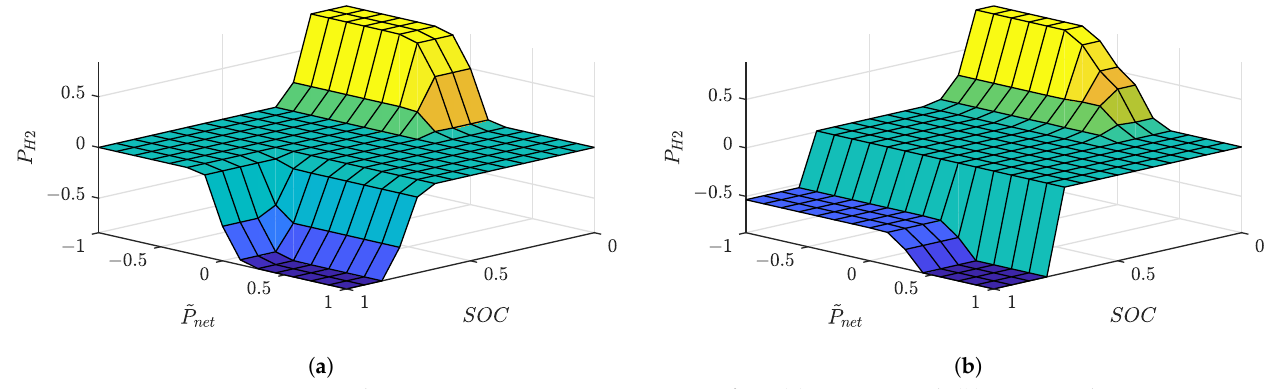
Figure 16. Fuzzy logic energy management output surface. ( a ) Expert tuned. ( b ) Optimized. The performance indicators for the different tunings—expert tuned (Expert), opti- mized rule base (OptRule), expert adapted optimized rule base (OptRuleE) and optimized rule and membership functions (OptMF)—are shown in Table 5. Table 5. Result of optimization